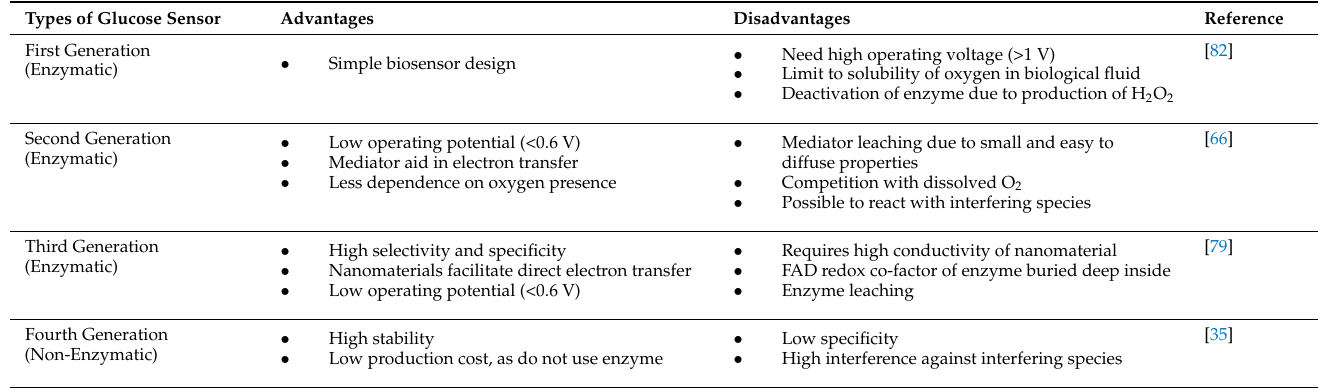
Table 1. The advantages and disadvantages of all generation of glucose